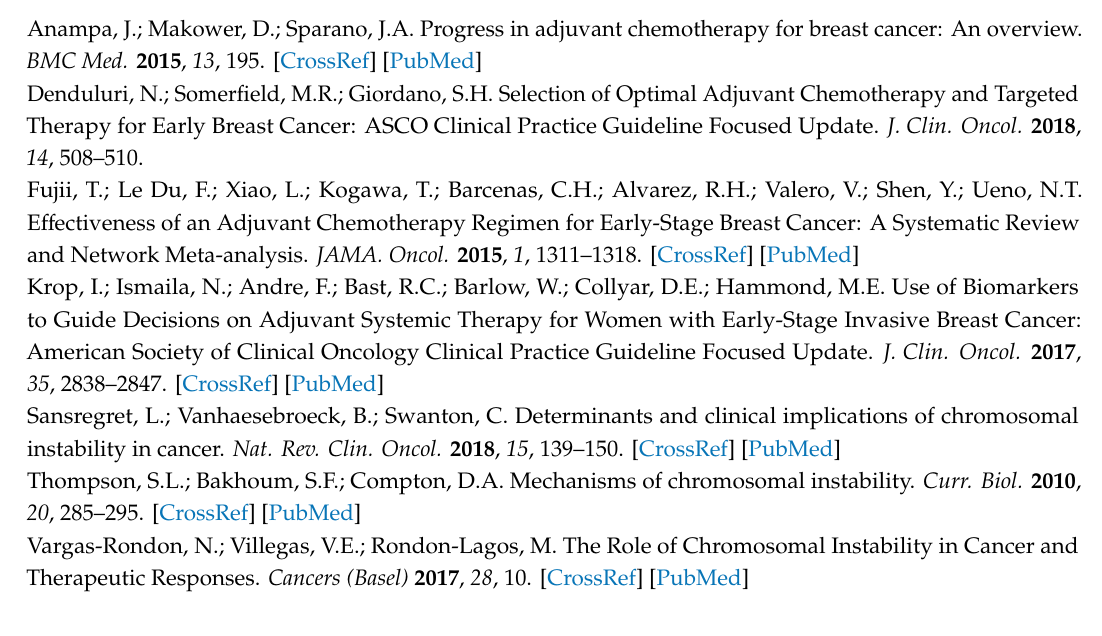
Table S1: Clinicopathological characteristics in the METABRIC cohort, Table S2: List of DNA repair genes tested in the METABRIC cohort, Table S3: Cohort ID and gene expression platform Multicentre (MC)-Adjuvant cohort (n = 4640), Table S4: Demographics of Multicentre (MC)-Adjuvant cohort (n = 4640), Table S5: Multicentre (MC) Neo-Adjuvant cohort (n = 2345), Table S6: Demographics in TOP trial cohort, Table S7: Clinicopathological characteristics of Nottingham historical early, TableS8: Table of antibodies and optimisation conditions used to immunohistochemically profile the Nottingham University Hospitals based cohorts. Detailed below are: Antigens, primary antibodies, clone, source, optimal dilution and scoring system, used for each immunohistochemical marker stage cohort (NUH-ESBC), Table S9: Clinicopathological characteristics of ER- cohort, Table S10: Multivariate backward step-wise Cox analysis for DNA repair genes, associated with Overall Survival (OS) in ER + METABRIC cohort, Table S11: Clinicopathological significance of ERCC1 protein expression in breast cancers, Table S12: Multivariate Cox regression analysis for breast cancer specific survival (BCSS) at 20 years follow up in Nottingham series including interaction